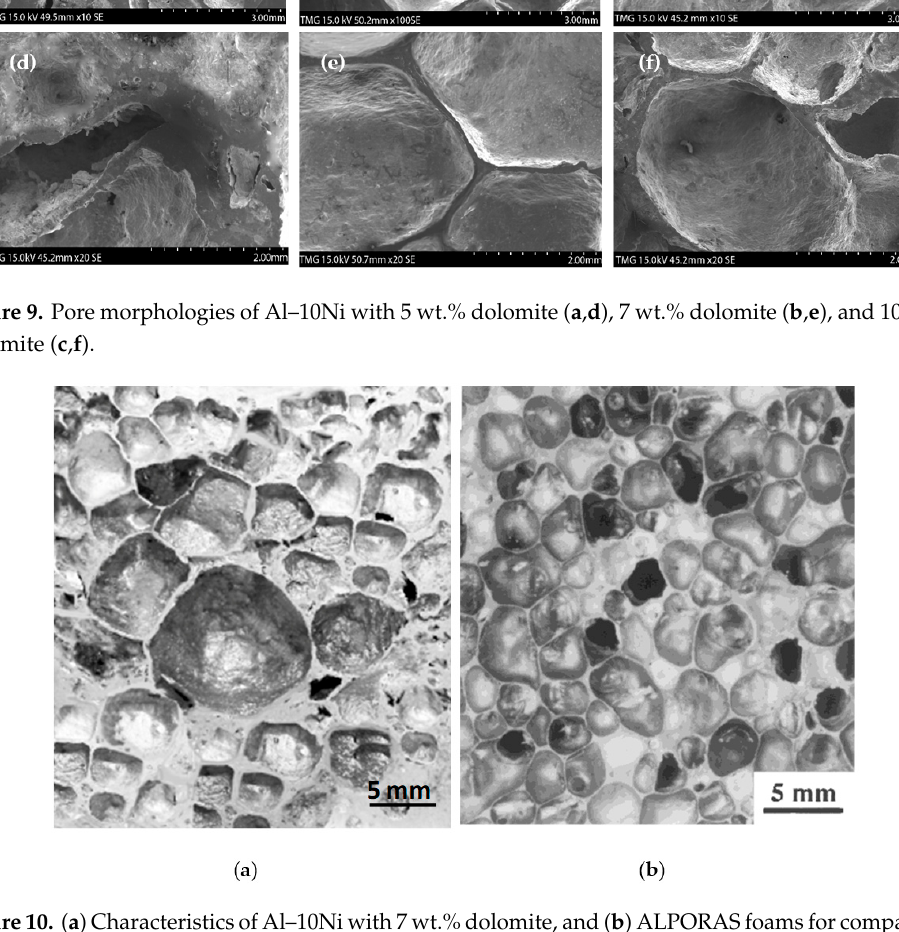
Figure 10. ( a ) Characteristics of Al–10Ni with 7 wt.% dolomite, and ( b ) ALPORAS foams for comparison purposes